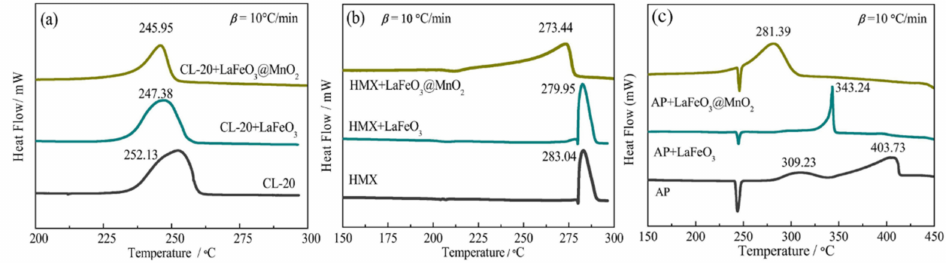
Figure 9. DSC curves for ( a ) CL-20 and ( b ) HMX ( c ) AP with different catalysts. ( a – c ) Reproduced with the permission of ref. [59]. Copyright 2020, Advanced Powder